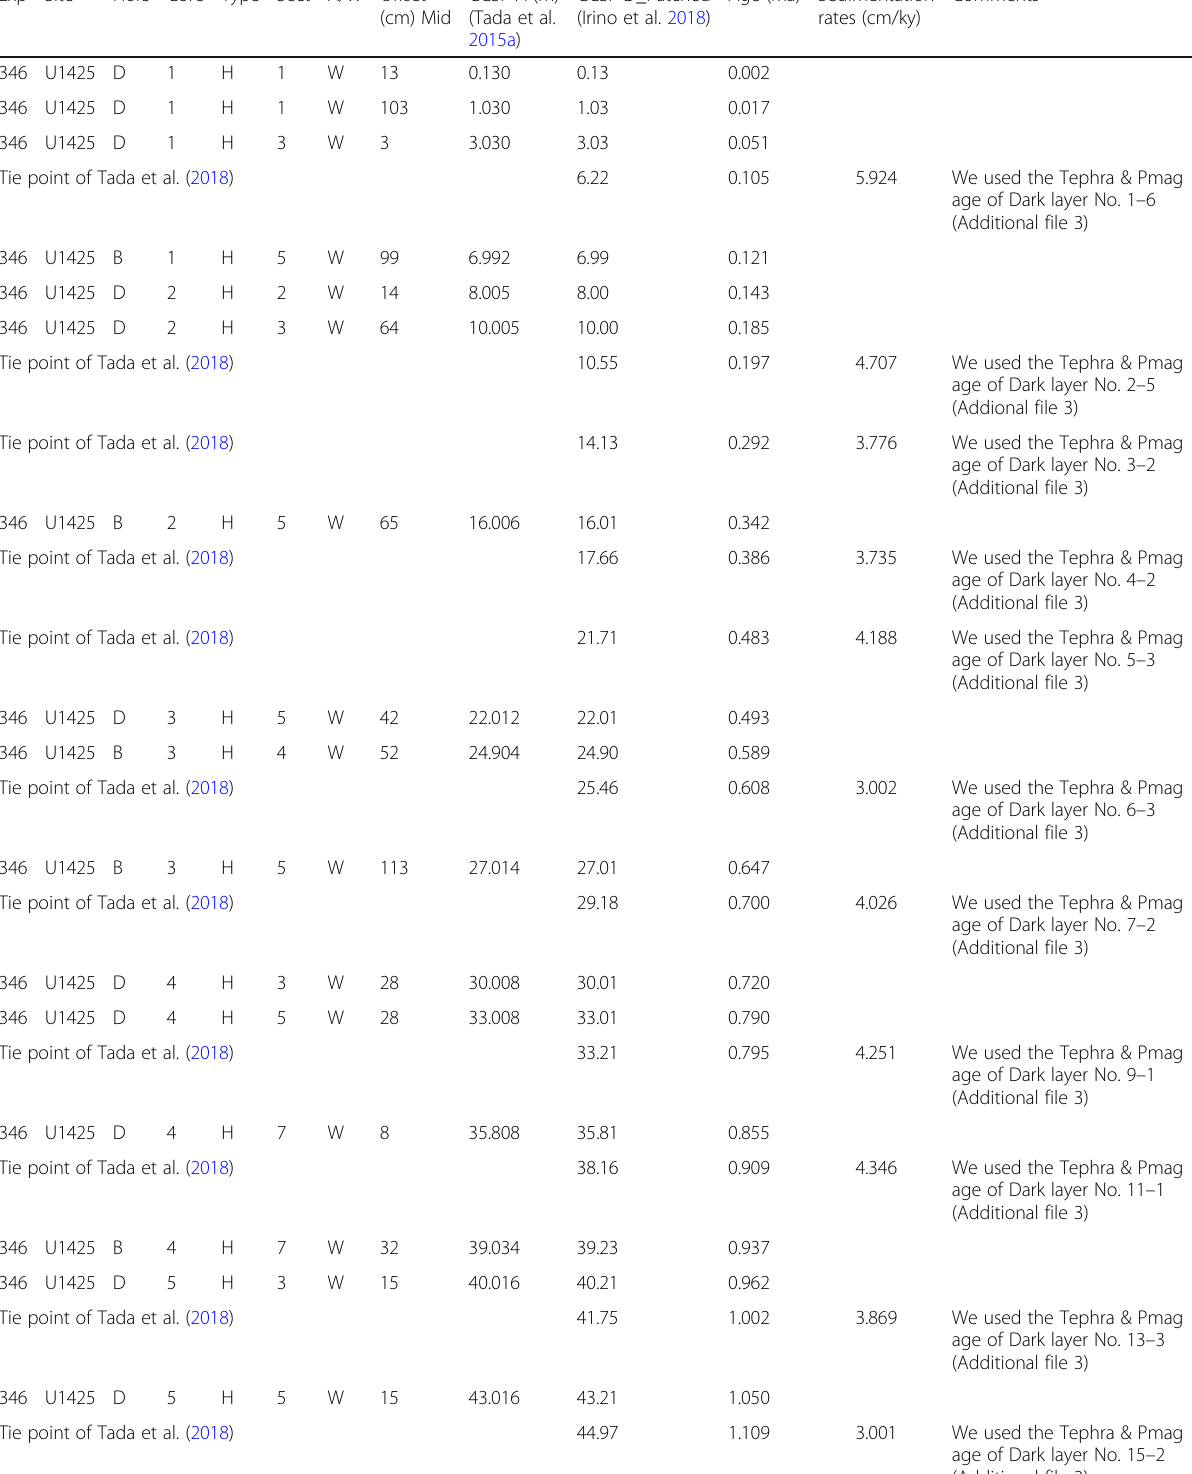
Table 1 Samples used, biostratigraphic tie points, and related sedimentation rates at IODP Site U1425 (cm/ky) Exp